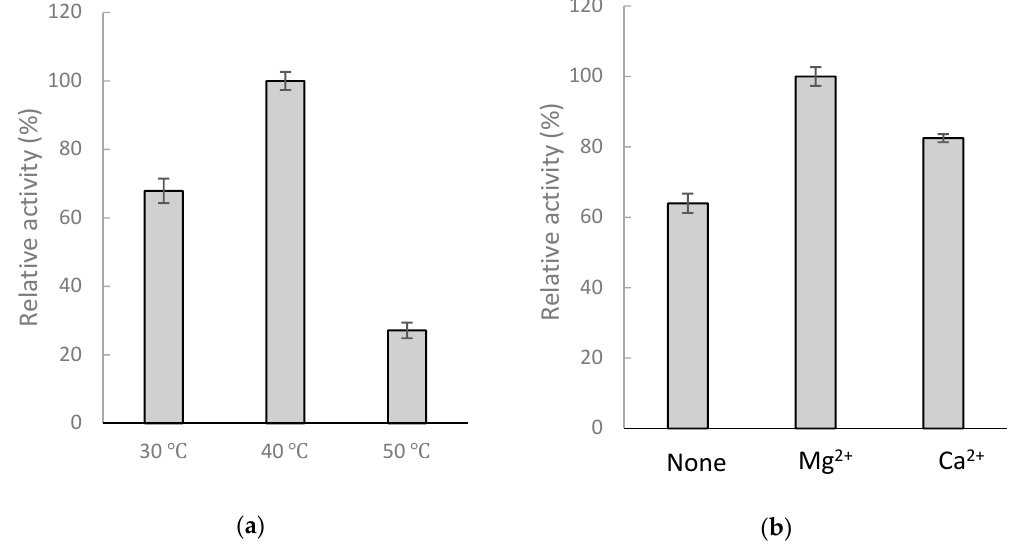
Figure 3. The production of compound ( 2 ) from GAA by BsGT110 under different temperature or metal ion conditions. The standard condition was set as 15 μ g/mL purified enzyme, 1 mg/mL GAA, 10 mM MgCl 2 , and 10 mM UDP-glucose in 50 mM acetate buffer at pH 6.0 and 40 °C. The tests were carried out by changing only the temperature ( a ) or metal ions ( b ) and maintaining all other settings. Relative activities were obtained by dividing the area summation of the UPLC reaction peak of the test condition by that of the standard condition. The data are expressed as mean ± SD, n = 3.